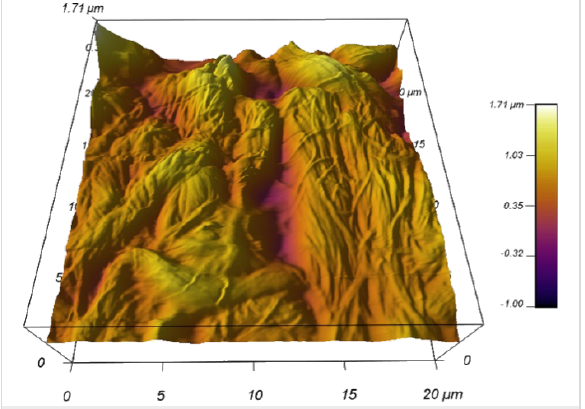
Figure 5: 3D reconstruction of AFM image on non-tattoo portion of the skin tissue under aqueous conditions (UHQ water).